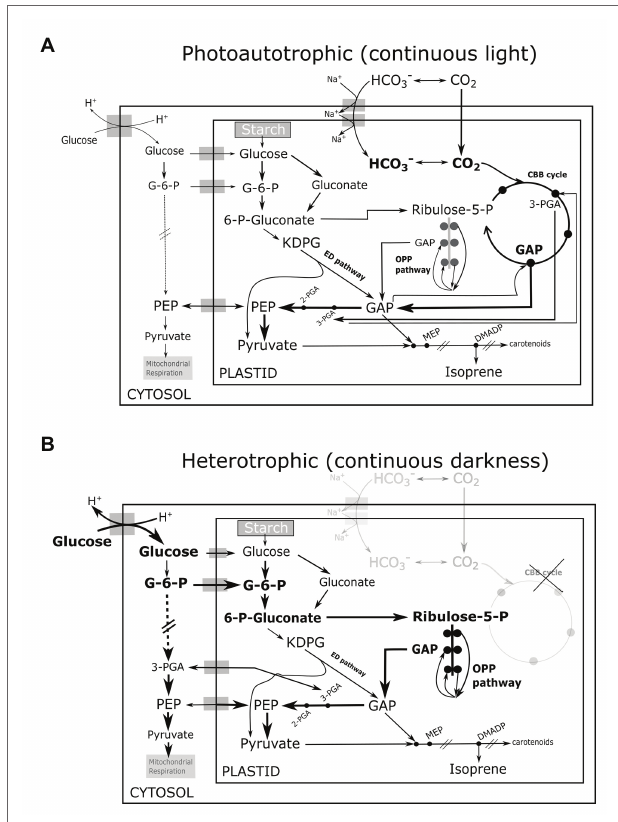
FIGURE 2 | Illustration of proposed interactions among glycolytic pathways, photosynthesis, and isoprene biosynthesis in (A) photoautotrophic eukaryotes in continous light (B) heterotrophic eukaryotes in continuous darkness. Metabolic cross-talk among CBB cycle (active only in light), the three glycolytic pathways namely the OPP pathway, the ED pathway, and cytosolic glysolysis, is indicated by prominent arrows. The thickness of arrows indicate the potential flux strength. The CBB cycle and glycolytic pathways co-contribute GAP, pyruvate to the MEP pathway and isoprene synthesis in light. The three glycolytic pathways sustain carbon and energy supply for isoprene synthesis in darkness. CBB, Calvin- Benson-Bassham; OPP, oxidative pentose phosphate; G-6-P, glucose-6- phosphate; ED, Entner-Doudoroff; 6-P-gluconate, 6-phosphogluconate; KDPG, 2-keto-3-deoxy-6-phosphogluconate; Ribulose-5-P, ribulose-5-phosphate; 3-PGA, 3-phosphoglycerate; 2-PGA, 2-phosphoglycerate; GAP, glyceraldehyde- 3-phosphate; PEP, 2-phosphoenol pyruvate; MEP, 2-C-methyl-D-erythritol 4-phosphate; and DMADP, dimethylallyl